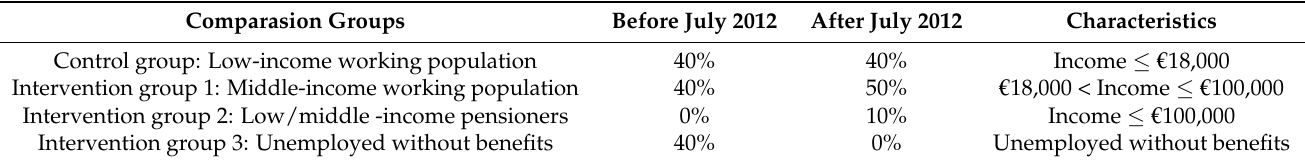
Table 2. Co-insurance rate changes for control and intervention groups in